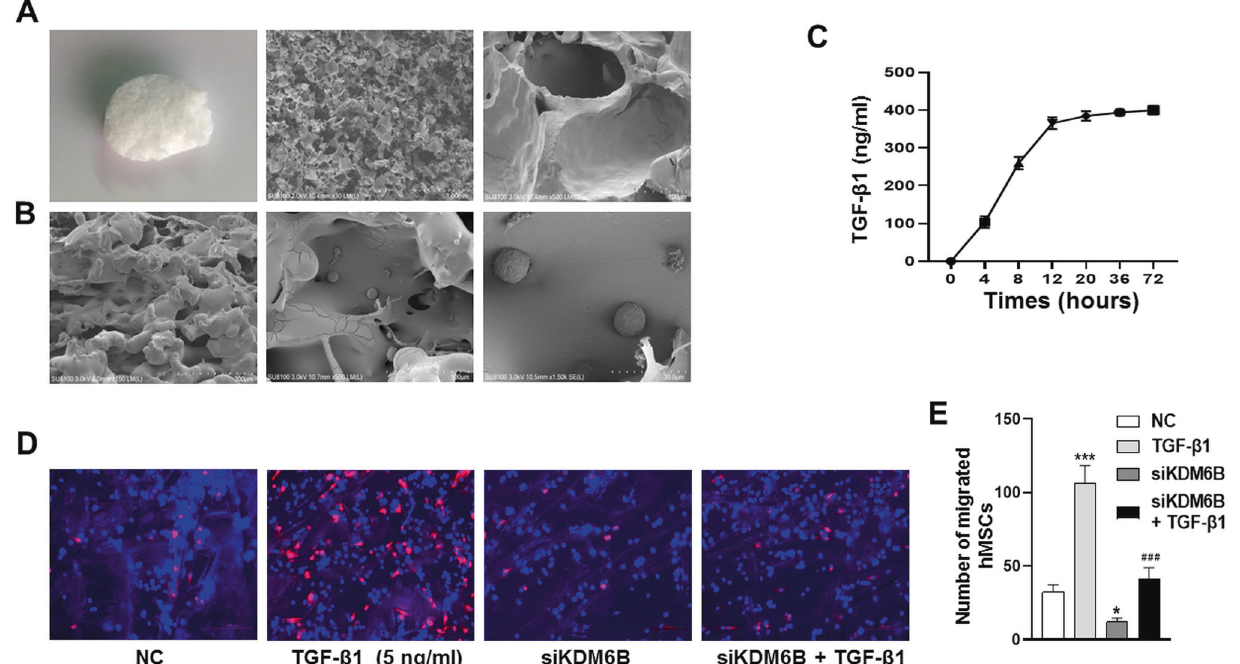
Fig. 3 The siRNA-KDM6B inhibited BMSCs homing promoted by TGF- β 1 in vivo. A The appearance shape and internal microstructure SEM of PLGA scaffold. B BMSCs are adhered on the scaffolds under SEM. C The ef fi ciency of TGF - β 1 released from PLGA scaffold. D The CM-Dil labeled BMSCs migrated to PLGA scaffold in vivo. E The relative quantitative of migrated BMSCs. ( * P <0.05, *** P <0.001 in comparison with the control group; ### P <0.001 in comparison with TGF - β 1 group. All experiments were repeated three times independently. All error bars ± standard